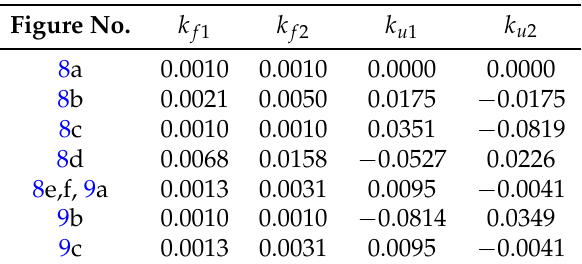
Table 2. Steady-state analysis: droop gains. Figure